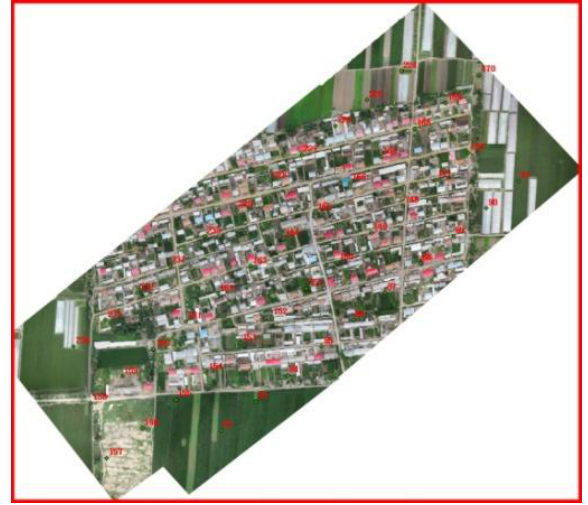
Figure 2. Flight rout graph of area 2